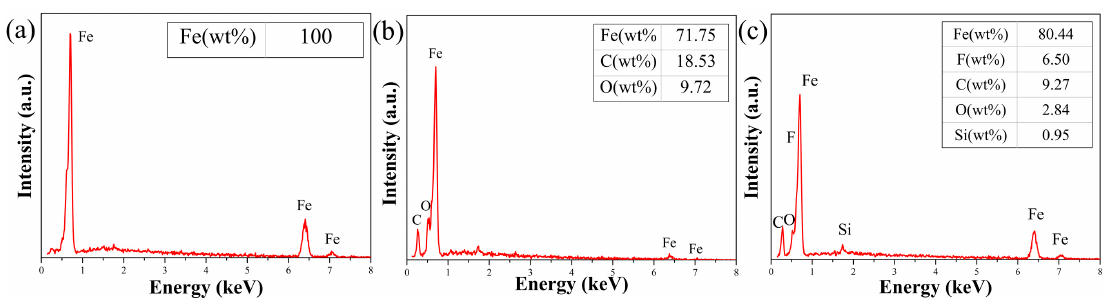
Figure 1. SEM images of polished Q235 carbon steel surface ( a ), structured Q235 carbon steel surface ( b ) and structured surface after modification of PFTEOS ( c ). (-2 is the high magnification image of -1, respectively).